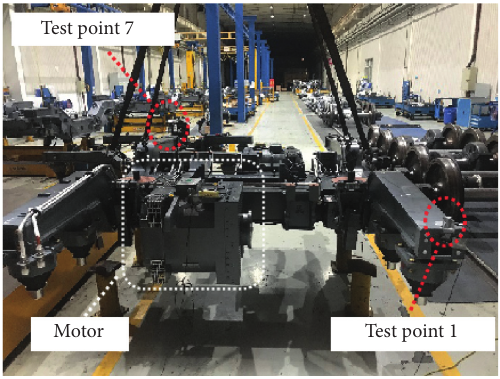
Motor Figure 3: Experimental modal test for the bogie frame.